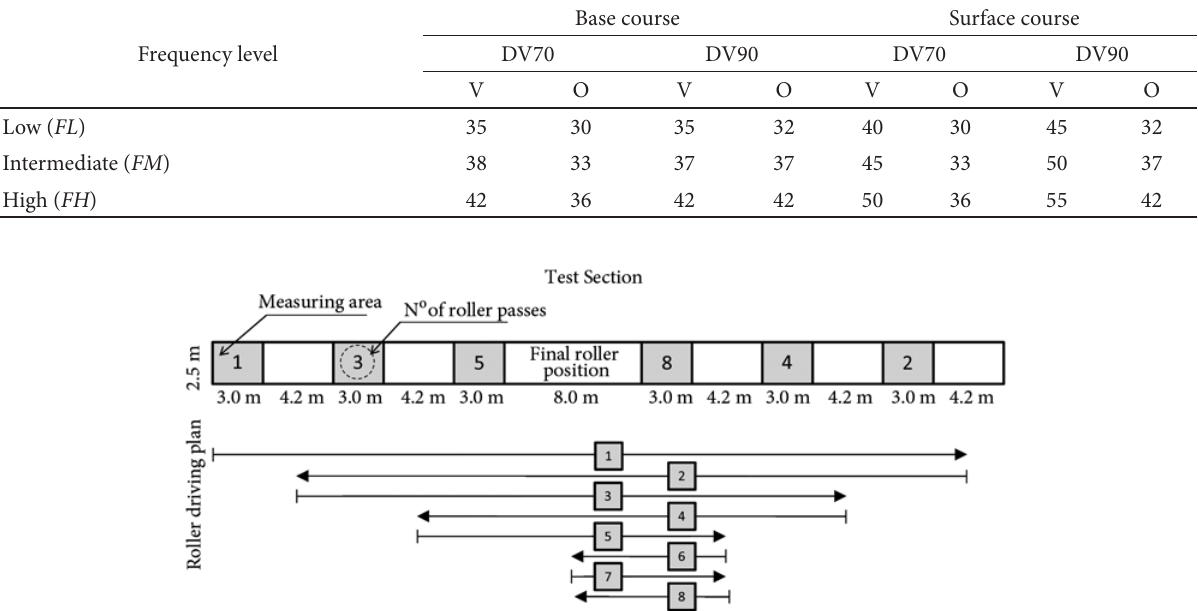
fig. 4. Paving and roller compaction